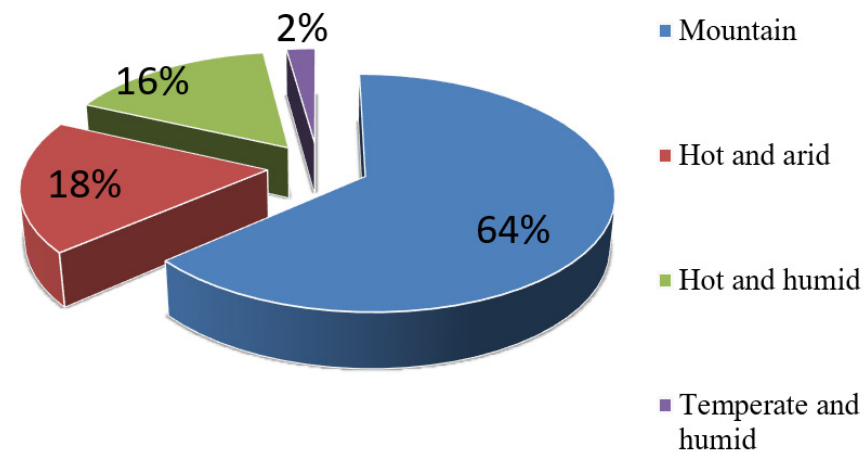
Figure 1. Climate ratio of Iranian rock-cut regions.